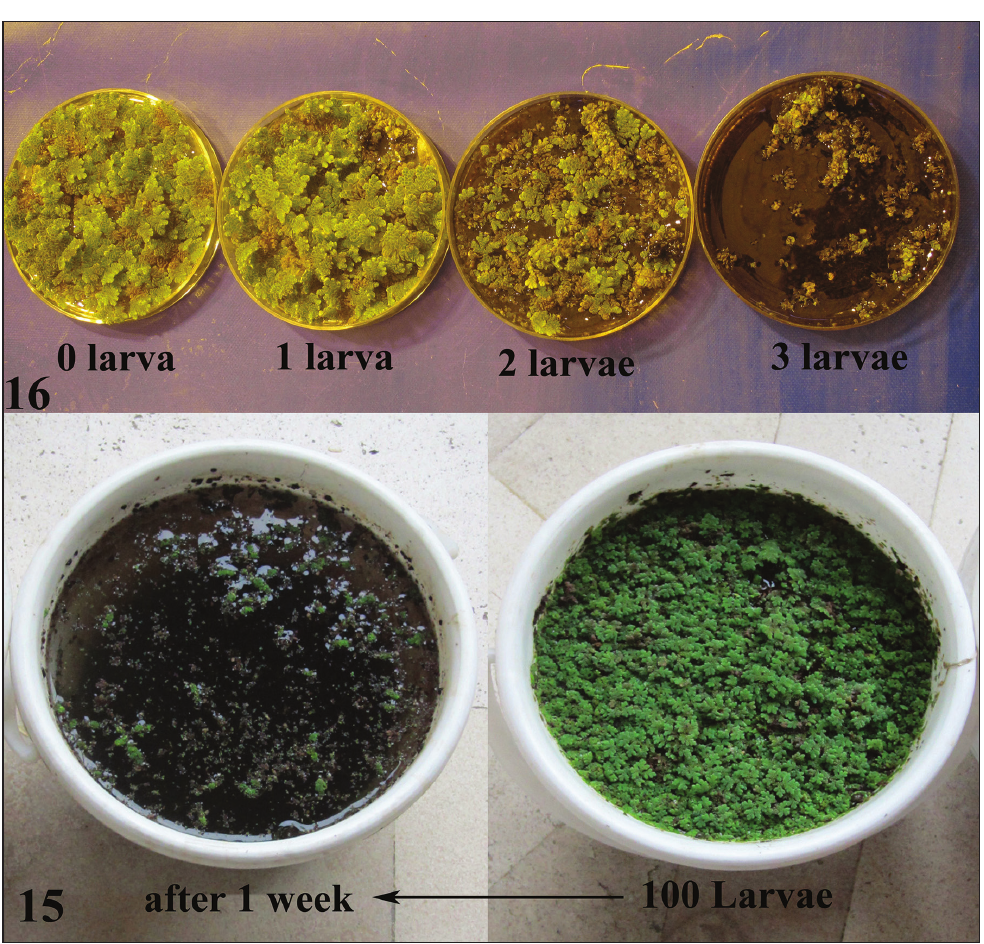
Figs 15–16. Cataclysta lemnata effects on water fern in the laboratory tests. 15. Petri dish test with different population density; 16. Larvae consuming the floating layer during a week of artificial infestation with high- density larval population in